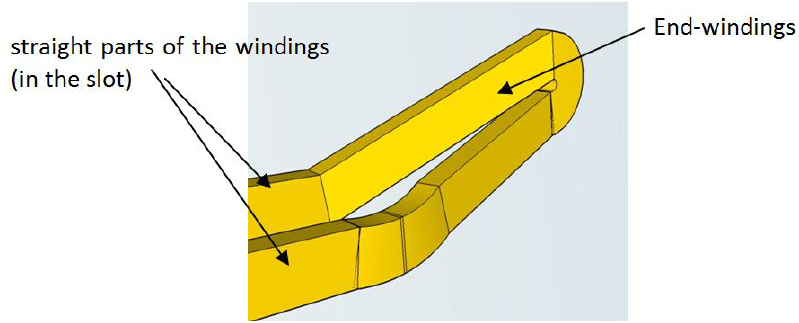
Figure 18. In the end-windings, the coil is bent to fit to the geometrical constraints due to the straight parts.